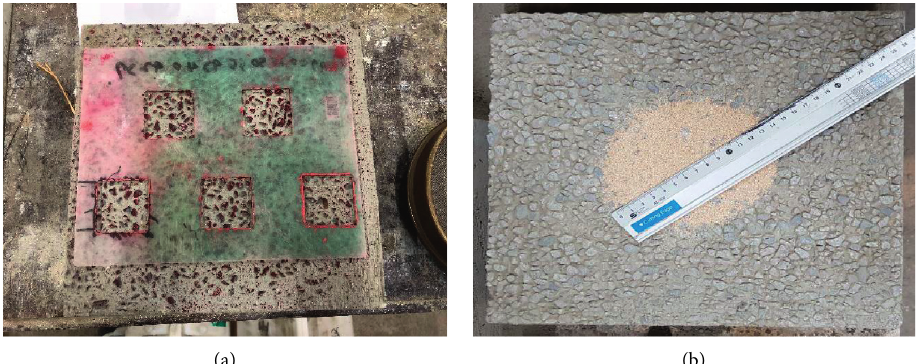
Figure 7: Measurement of (a) exposed aggregate number and (b) mean texture